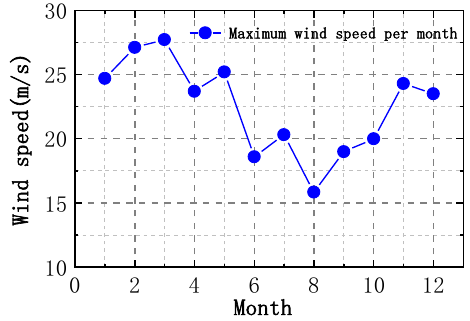
Figure 11. Distribution of maximum wind speed per month.